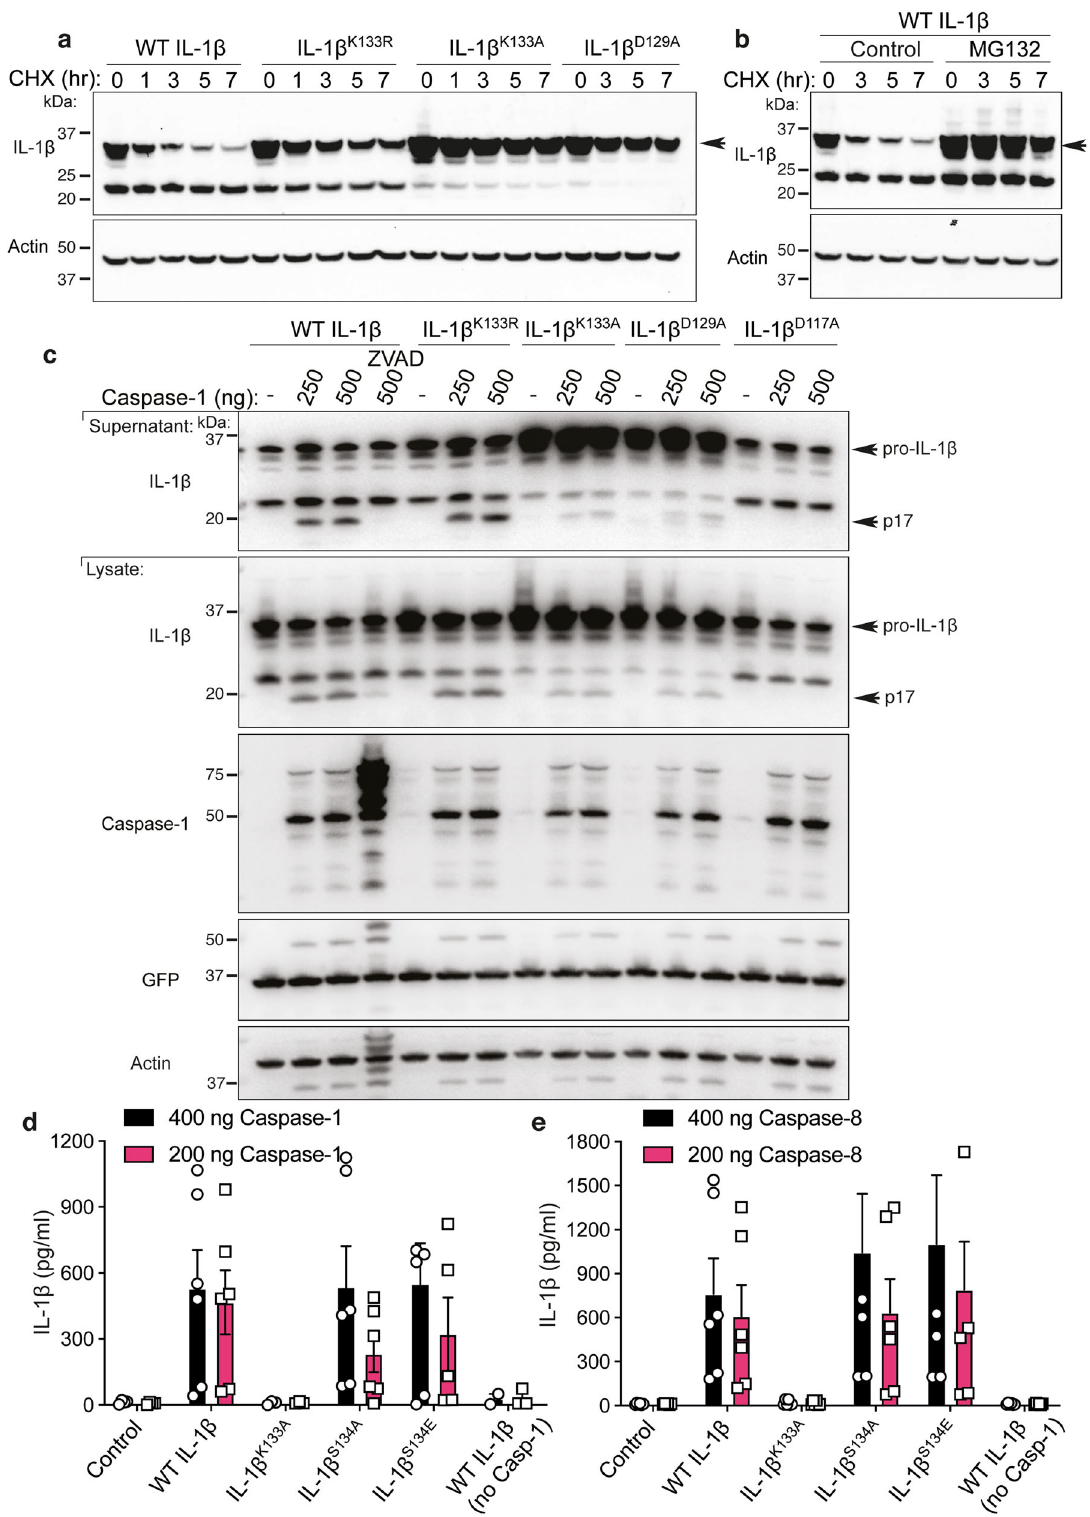
i fi ed cell supernatant (Supplementary Fig. 7a,